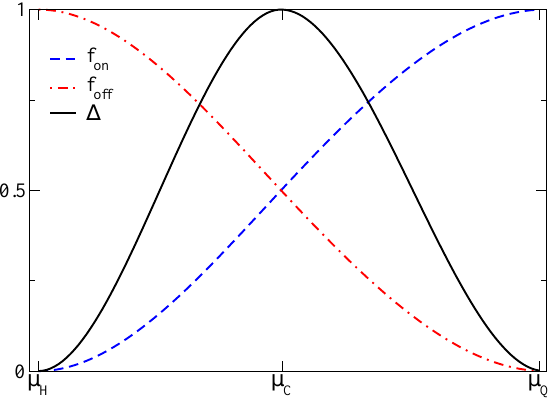
Figure 3. Polynomial switch functions f off/on ( µ ) as well as the function ∆ ( µ )